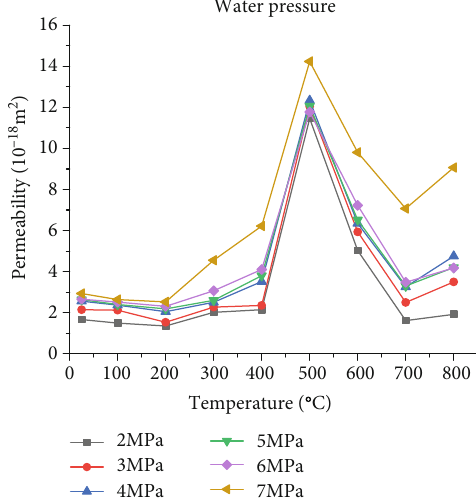
Figure 7: Permeability of the sandstones considering axial pressure 10 MPa and con fi ning pressure 12MPa considering di ff erent heated